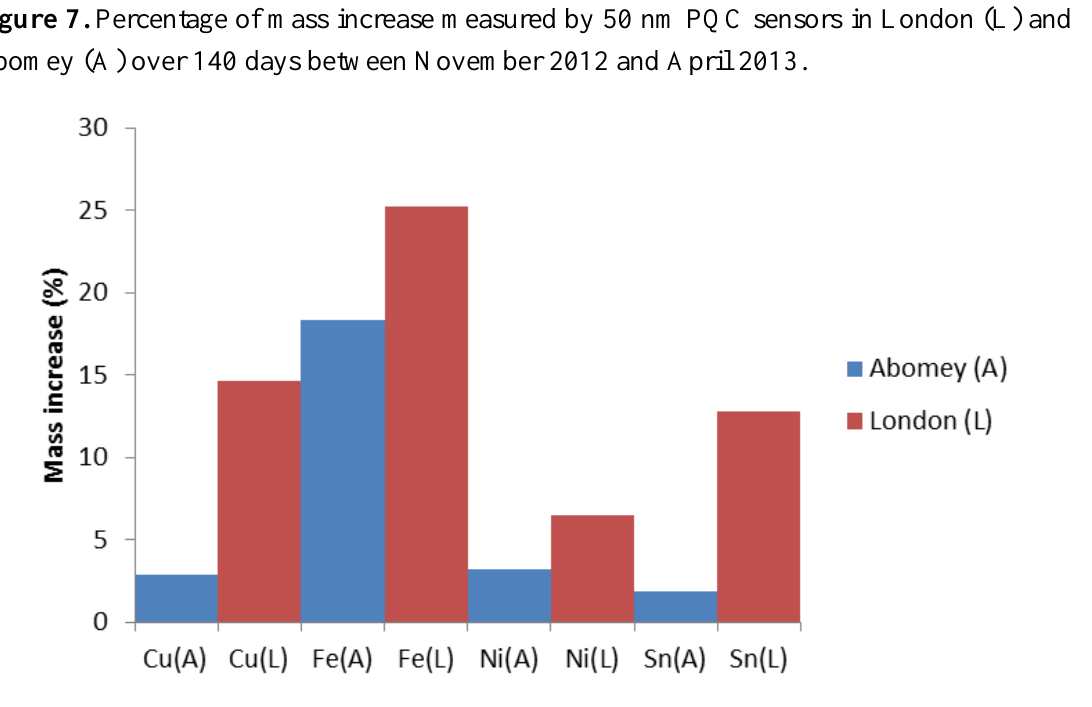
Figure 8. Daily averaged percentage of mass increase of 50-nm Fe sensors in Abomey and London during 140 days of exposure between November 2012 and April 2013 with standard deviations as error